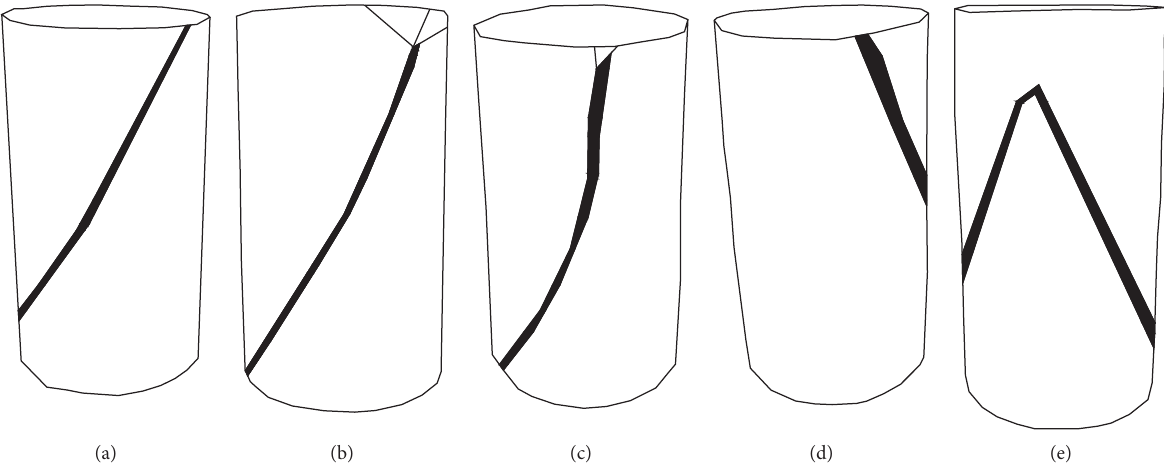
Figure 6: Sketch maps of specimen-fracture characteristics. (a) Pore pressure 0. (b) Pore pressure 0.1MPa. (c) Pore pressure 0.2 MPa. (d) Pore pressure 0.4MPa. (e) Pore pressure